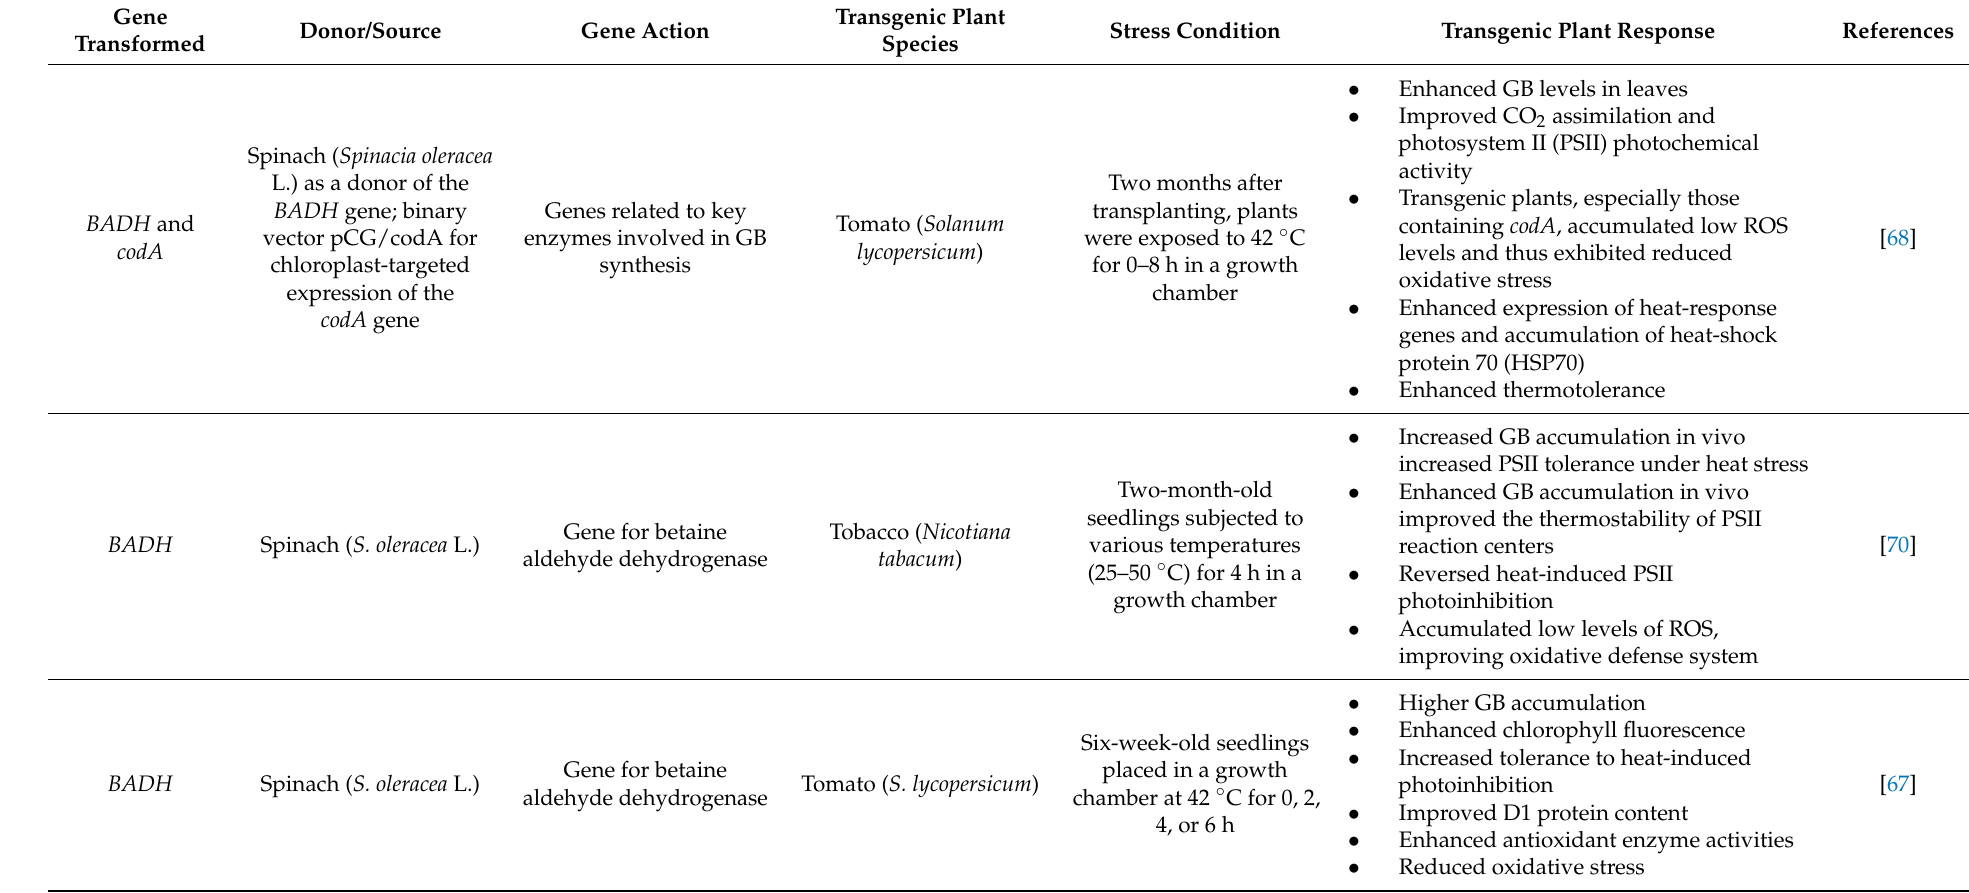
Table 3. Genetic engineering for enhanced GB accumulation and improved thermotolerance in different